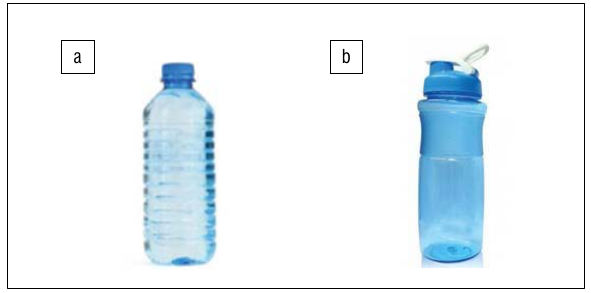
Samples of 0.5-L PET bottles: (a) single use and (b) reusable. Life cycle assessment is an important method used to analyse and quantify the potential environmental impacts and resource consumption associated with a product system. 26 Evaluating alternative plastic water bottles provides a foundation assessment for policymakers and plastic bottle manufacturers to make informed choices and to focus on improvements in environmental performance.